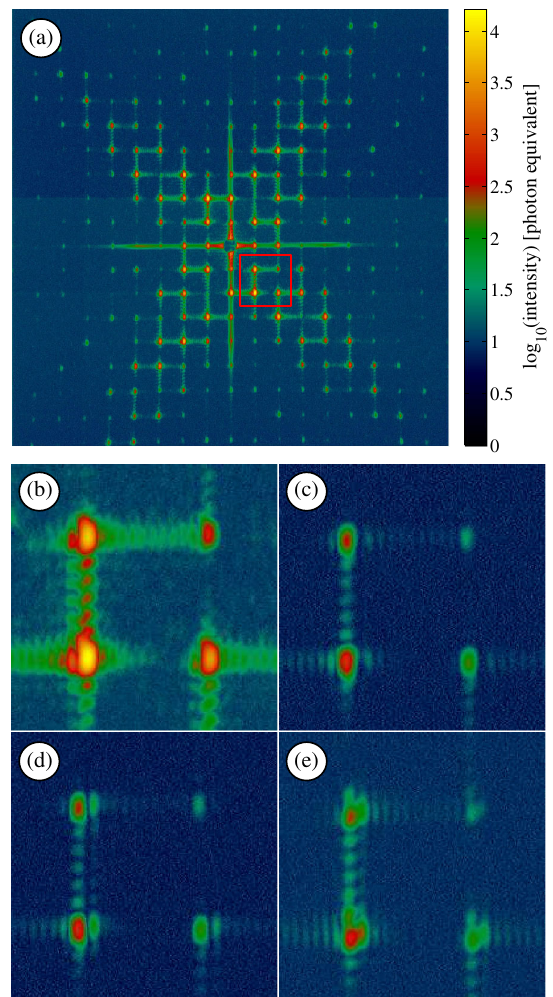
FIG. 3. (a) Single full-fluence shot of a 2D crystal target on a logarithmic intensity scale. The red rectangular box within the full pattern indicates the zoomed regions shown in panels (b-e). Panel (b) corresponds to that in the full pattern (a), while the additional three zoomed regions (c-e) were recorded from the same target but at lower fluence and with the target shifted by a few microns between shots. The breakdown of inversion sym- metry, and its sensitivity to beam position, is evident. The prominent central streaks of intensity, which are due to edge scatter from the Si window, were ignored throughout our data